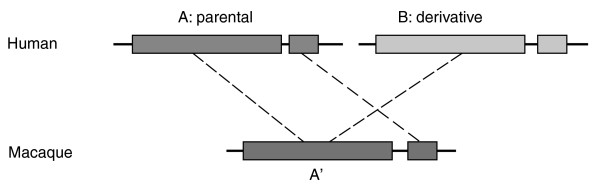
A cartoon illustrating the method used here for identifying post-macaque SDs based on chromosomal synteny. Using the liftOver tool [29] from the UCSC genome browser group, a pair of human SDs (A and B) is mapped to the same location (A') in the macaque genome. A and B (large block) are thus considered the product of an SD event that occurred after the split of human from macaque lineages. Then 1 kb sequences (small block) adjacent to A or B were aligned to the macaque genome. If only the sequence next to A was mapped next to A', then A is designated as the parental copy and B as the derivative.